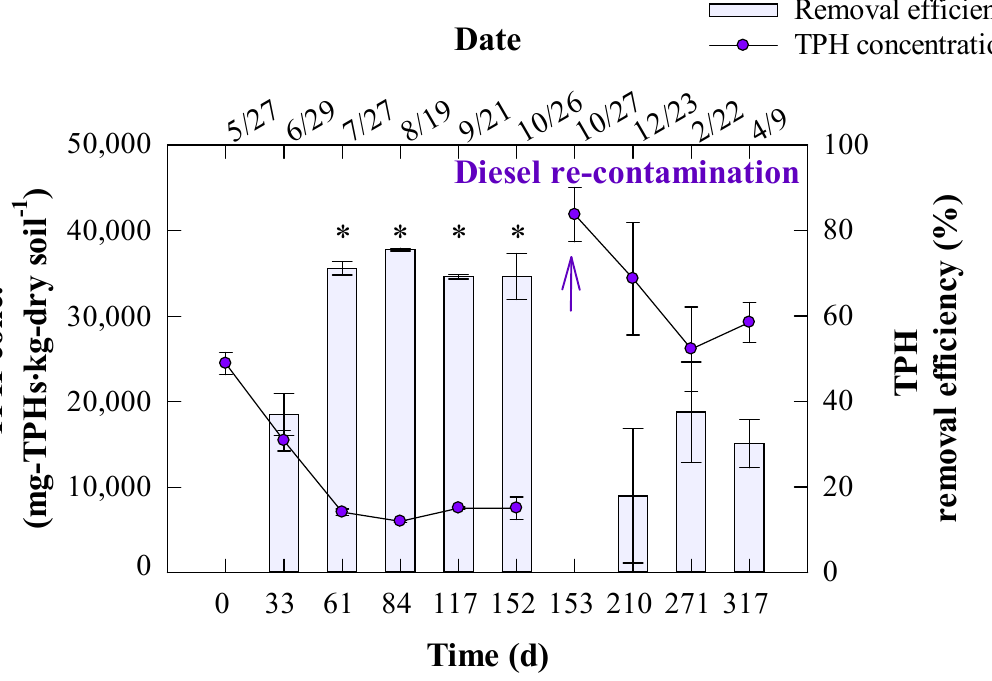
Figure 2. Residual TPH concentration and removal efficiency in the diesel-contaminated soil. Asterisks indicate significant differences ( p < 0.05).